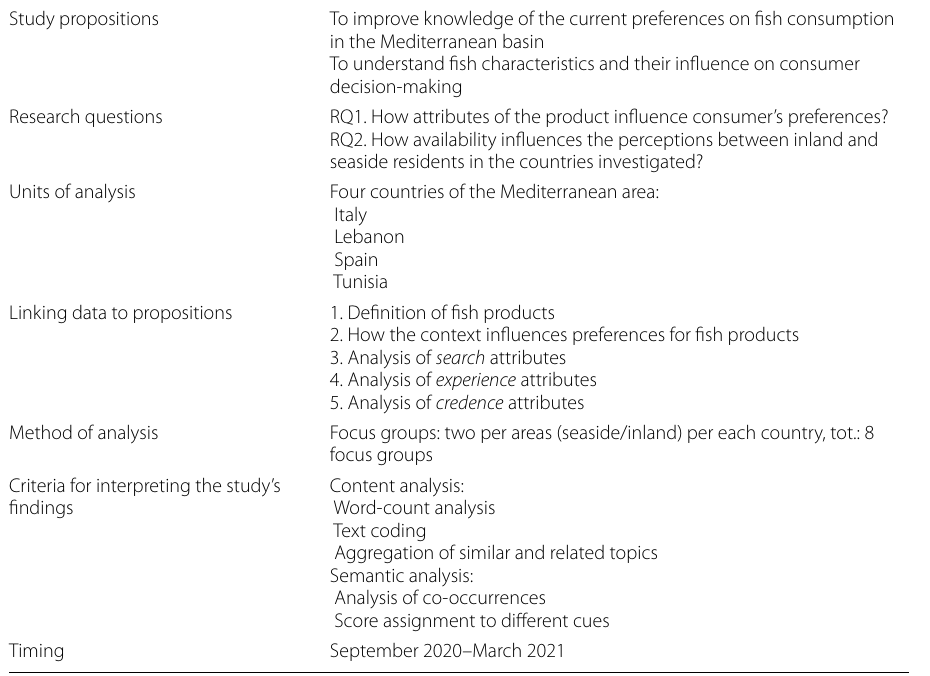
Table 1 Procedure adopted for the research Study propositions To improve knowledge of the current preferences on fish consumption in the Mediterranean basin To understand fish characteristics and their influence on consumer decision-making Research